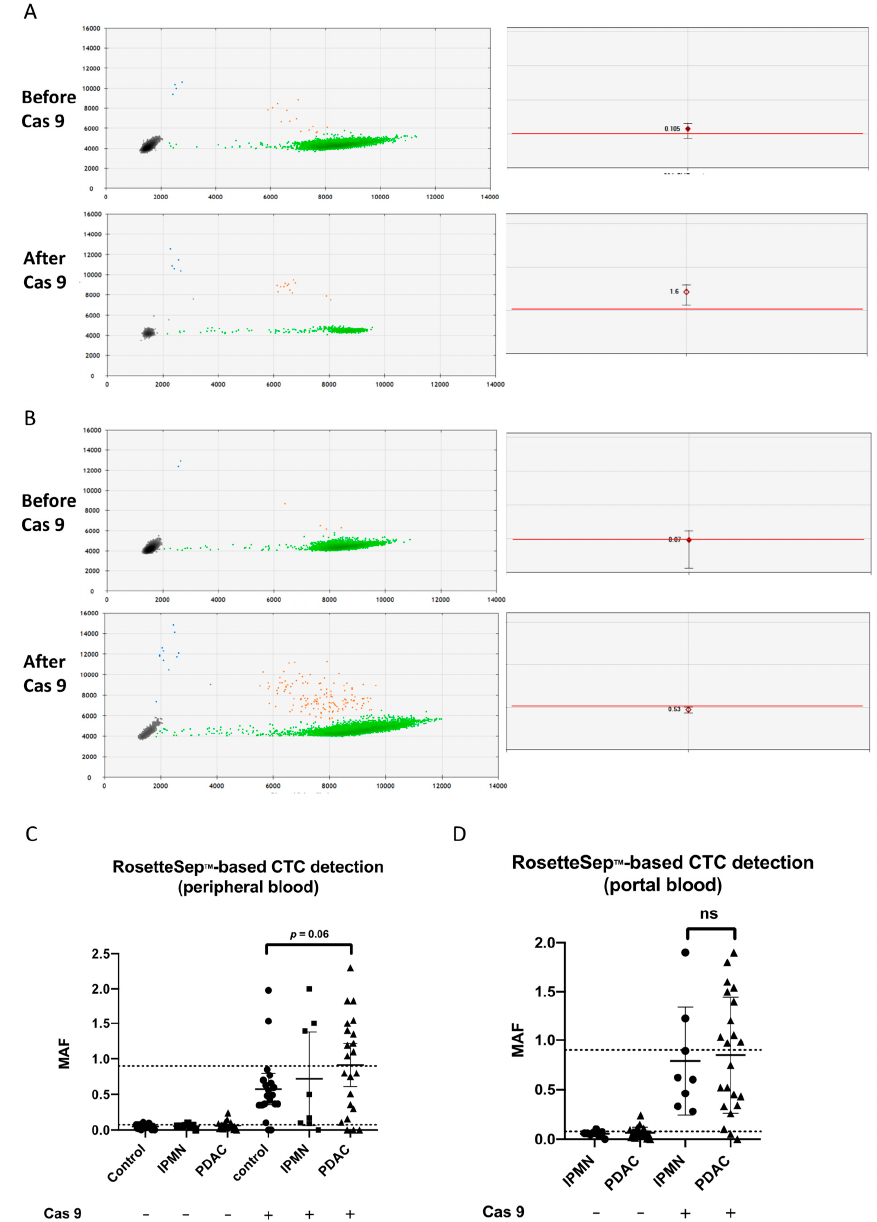
Figure 4. The ddPCR results for KRAS detection after CTC enrichment. ( A , B ) Individual droplet PCR fluorescence results are plotted as two-dimensional dot plots (left). Grey dots correspond to empty droplets. Green dots correspond to droplets containing wild-type (WT) copies of KRAS . Blue dots correspond to droplets containing one mutant KRAS allele. Orange dots correspond to droplets containing WT ( X -axis of the left panels corresponding to the HEX, hexachlorofluorescein succinimidyl ester fluorophore) and mutant alleles ( Y -axis of the left panels corresponding to the FAM, 6-carboxyfluoresceine fluorophore). On the right panels, MAFs are shown for individual results, with the maximum and the minimum values of triplicates; the red lines indicate the positivity threshold. Patient #36 ( A ) became positive and patient #39 ( B ) was negative for KRAS mutation before and after Cas9. ( C , D ) MAF of KRAS mutation by ddPCR after RosetteSep TM CTC enrichment. Greater median MAF in CTC-enriched samples after CRISPR / Cas9 cut of the wild-type KRAS allele as compared to uncut DNA in ( C ) peripheral and ( D ) portal blood. Higher median MAFs in patients compared with the control group tended toward significance ( p = 0.06 by Mann–Whitney test). MAF: mutant allele